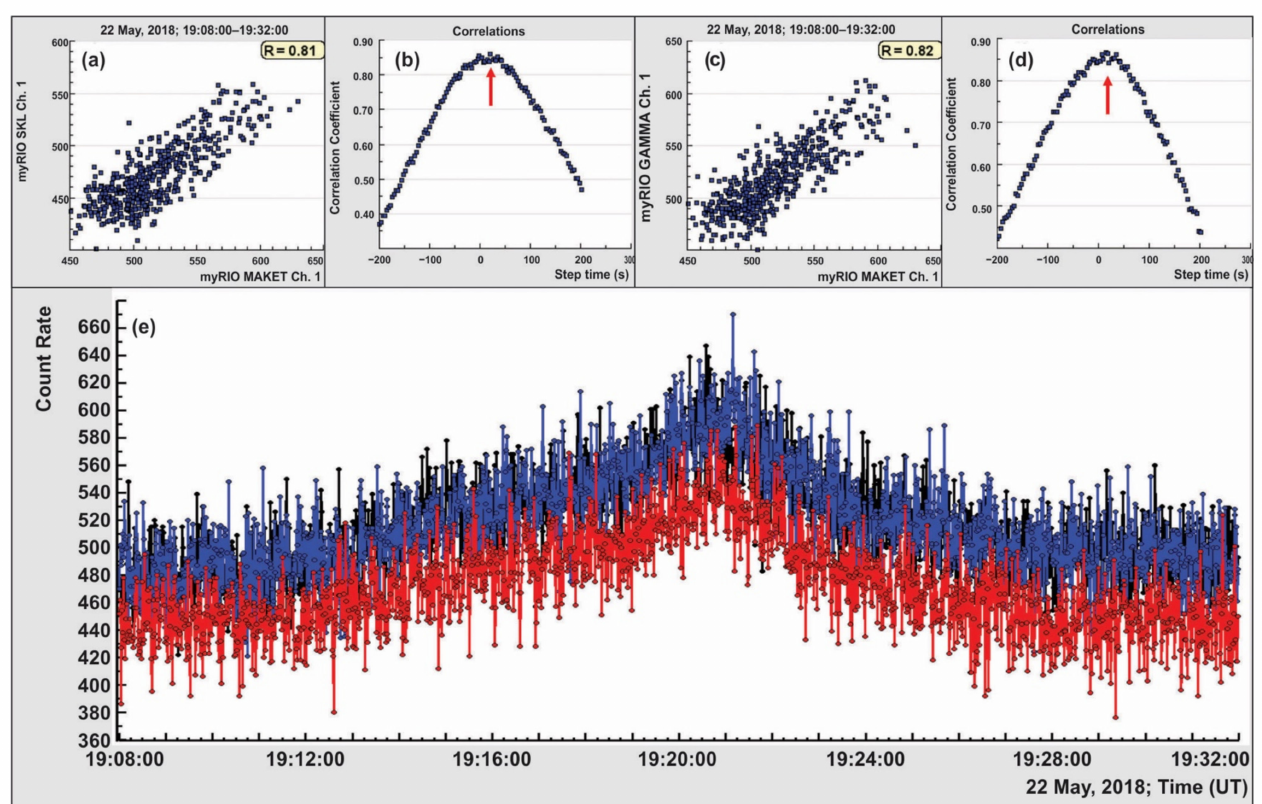
Figure 4. ( a , b ) scatter plots and delayed correlations plots (with a shift from − 200 to 200 s) of count rates of STAND1 detector’s upper 1 cm thick scintillators (MAKET and SKL detectors); ( c , d ) the same for the MAKET and GAMMA detectors; ( e ) 1s time series of count rates of all three units of STAND1 network: MAKET (black), GAMMA (blue), and SKL (red). By red arrows we show the maximum